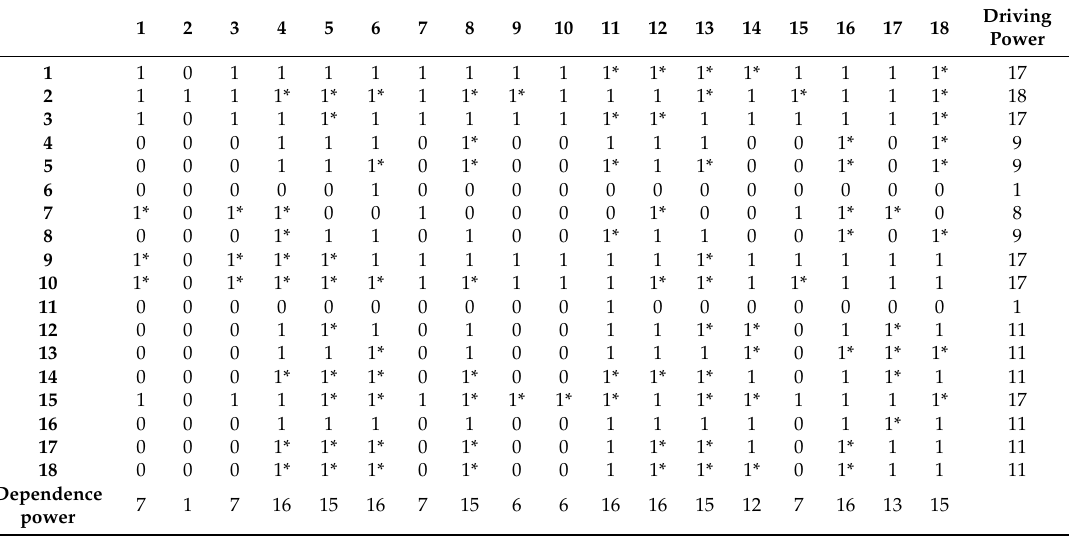
Table 5. Final reachability matrix for enablers of knowledge management implementation in the healthcare sector of